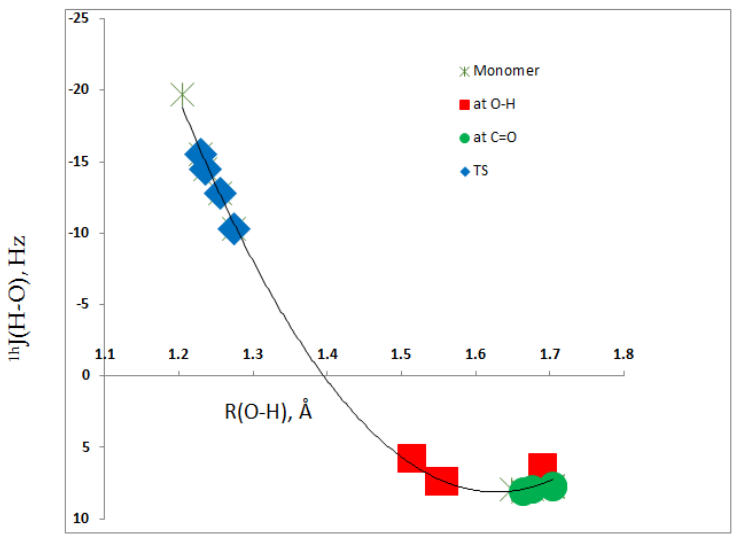
Figure 7. 1h J(O–H) versus the O–H distance for complexes 1 :Acid.